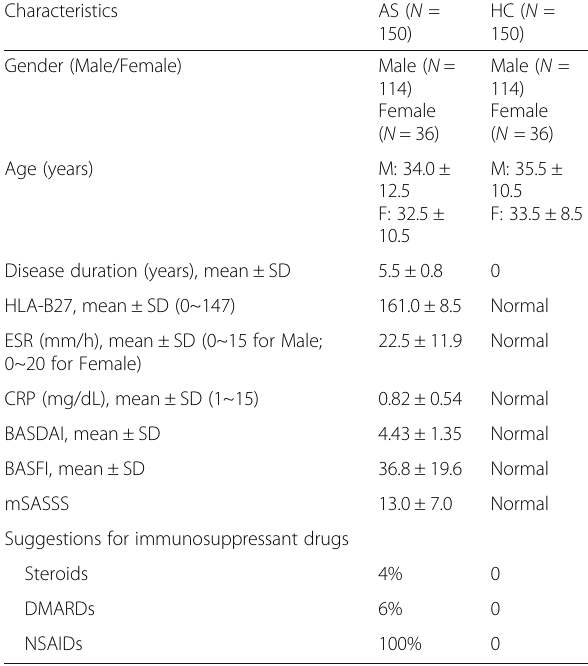
Table 1 Characteristics of healthy controls (HC) and AS patients